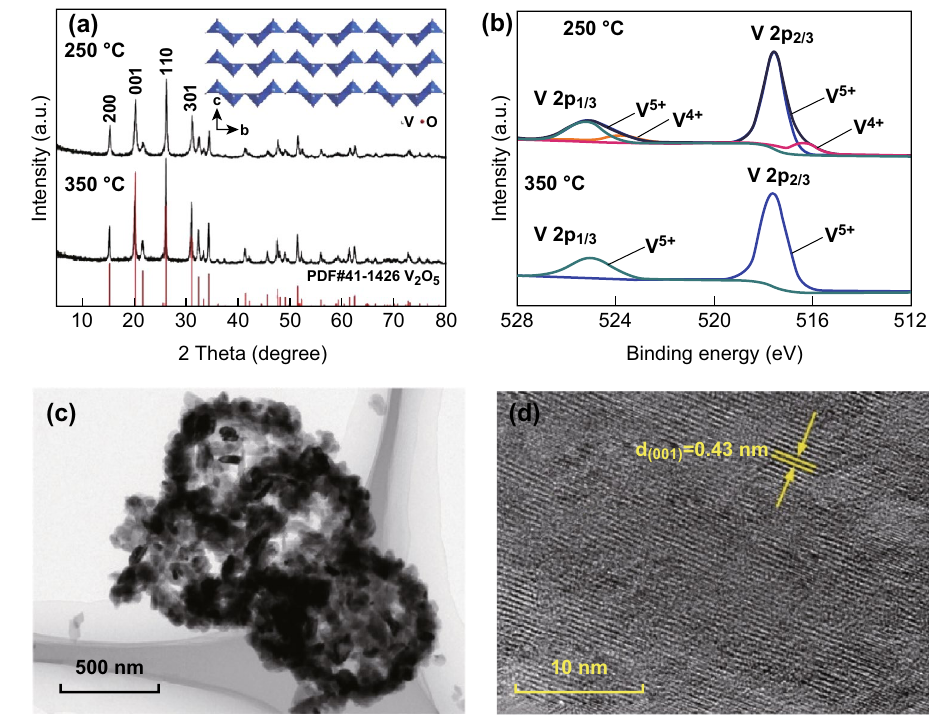
Fig. 2 a XRD pattern and crystal structure of V 4+ -V 2 O 5 . b XPS spectra for V 2p of V 4+ -V 2 O 5 and V 2 O 5 . c TEM image and d HRTEM image of V 4+